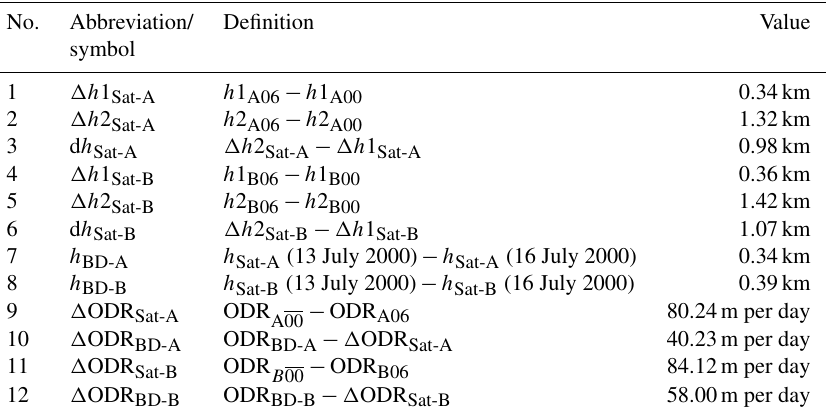
Table 4. Indices used to analyse and contrast the effects of intervals of elevated and exceptionally quiet geomagnetic activity with those of the Bastille Day